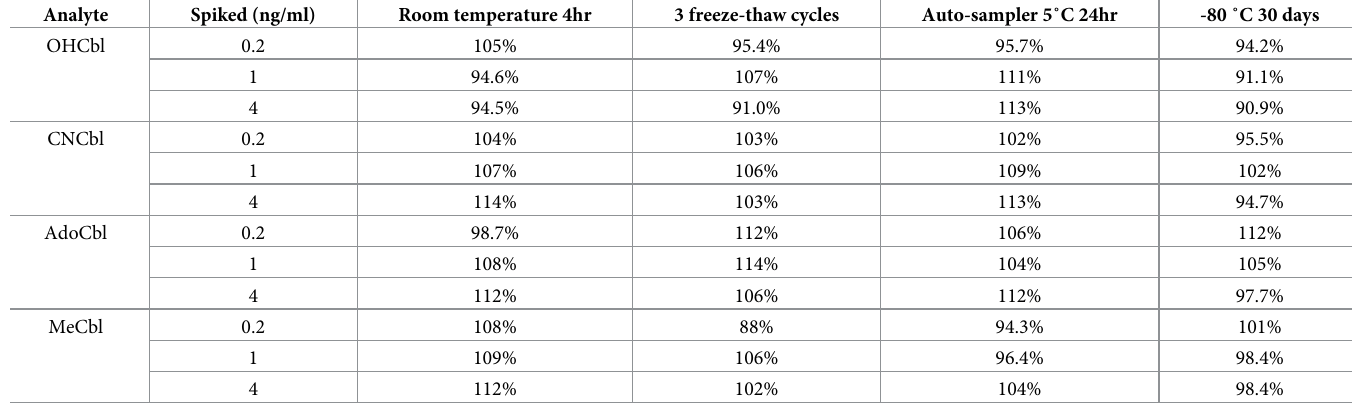
Table 5. Stability of four cobalamins in rat plasma in various stresses determined by SPE-HPLC-MS/MS (n = 3). Analyte Spiked (ng/ml) Room temperature 4hr 3 freeze-thaw